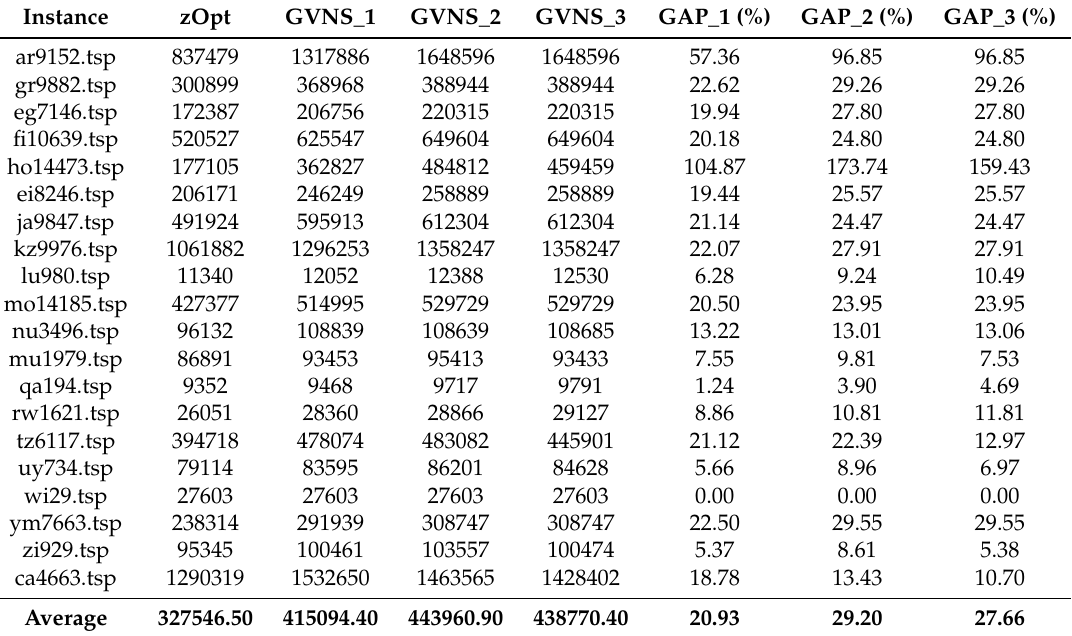
Table 10. Results using the Best Improvement search strategy and an execution time limit of 1 min.